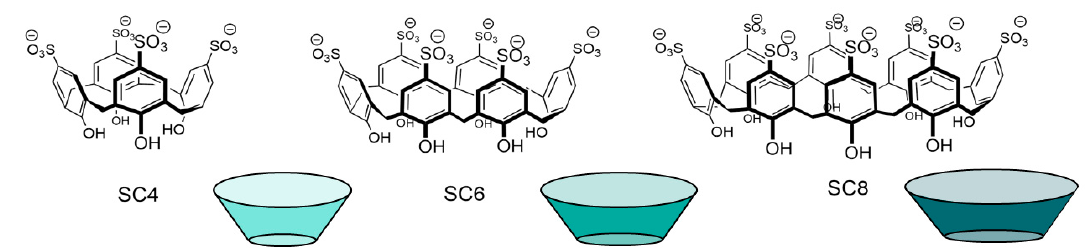
Figure 1. Structures of the p -sulfonatocalix[n]arene receptors, SCn, and corresponding schematizations of the macrocycles.